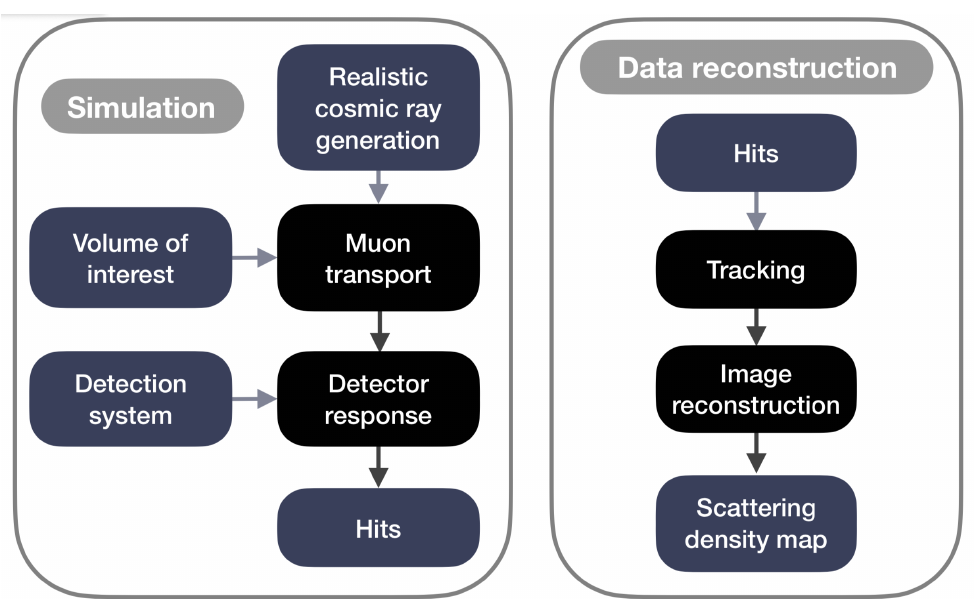
Figure 7. Typical muon scattering tomography simulation steps. In blue are simulated objects and in black are simulation